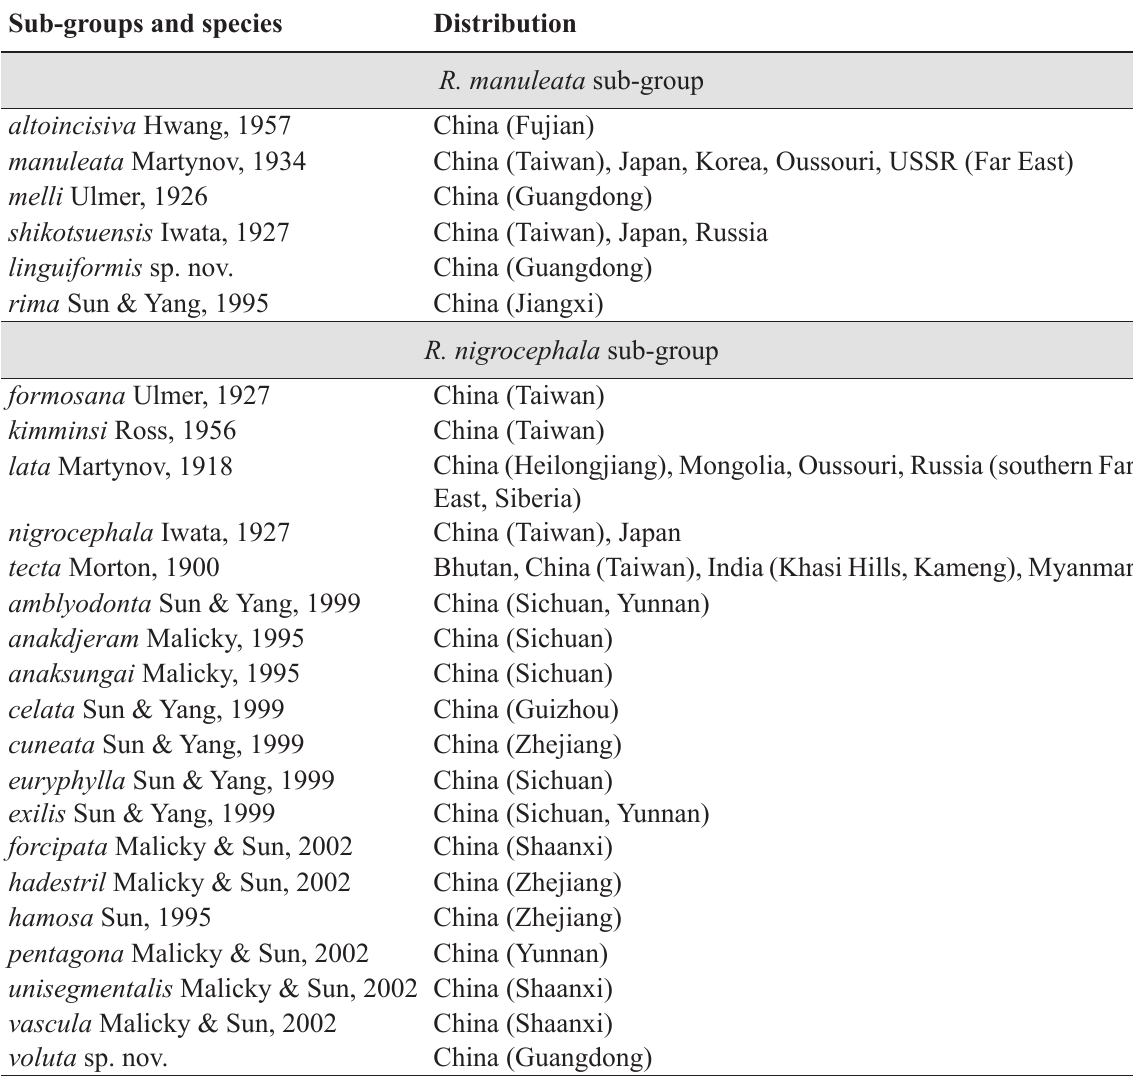
Table 1. Species of the Rhyacophila nigrocephala species-group recorded